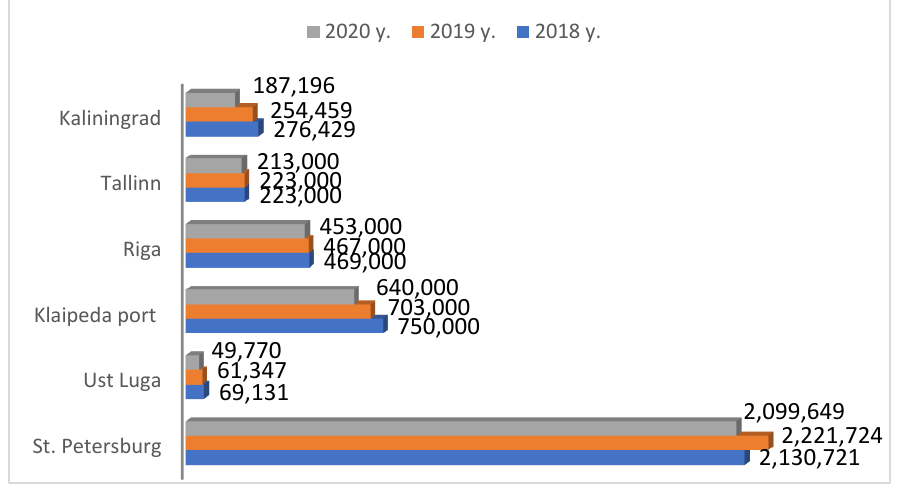
Figure 21. Container stevedoring ports in the Baltic region, TEU.